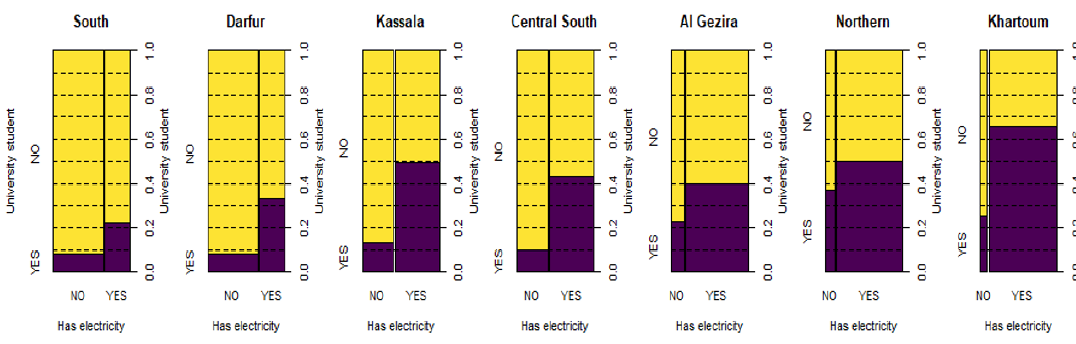
Figure 9. University attendance rates for 19–21-year-olds without/with electricity, by